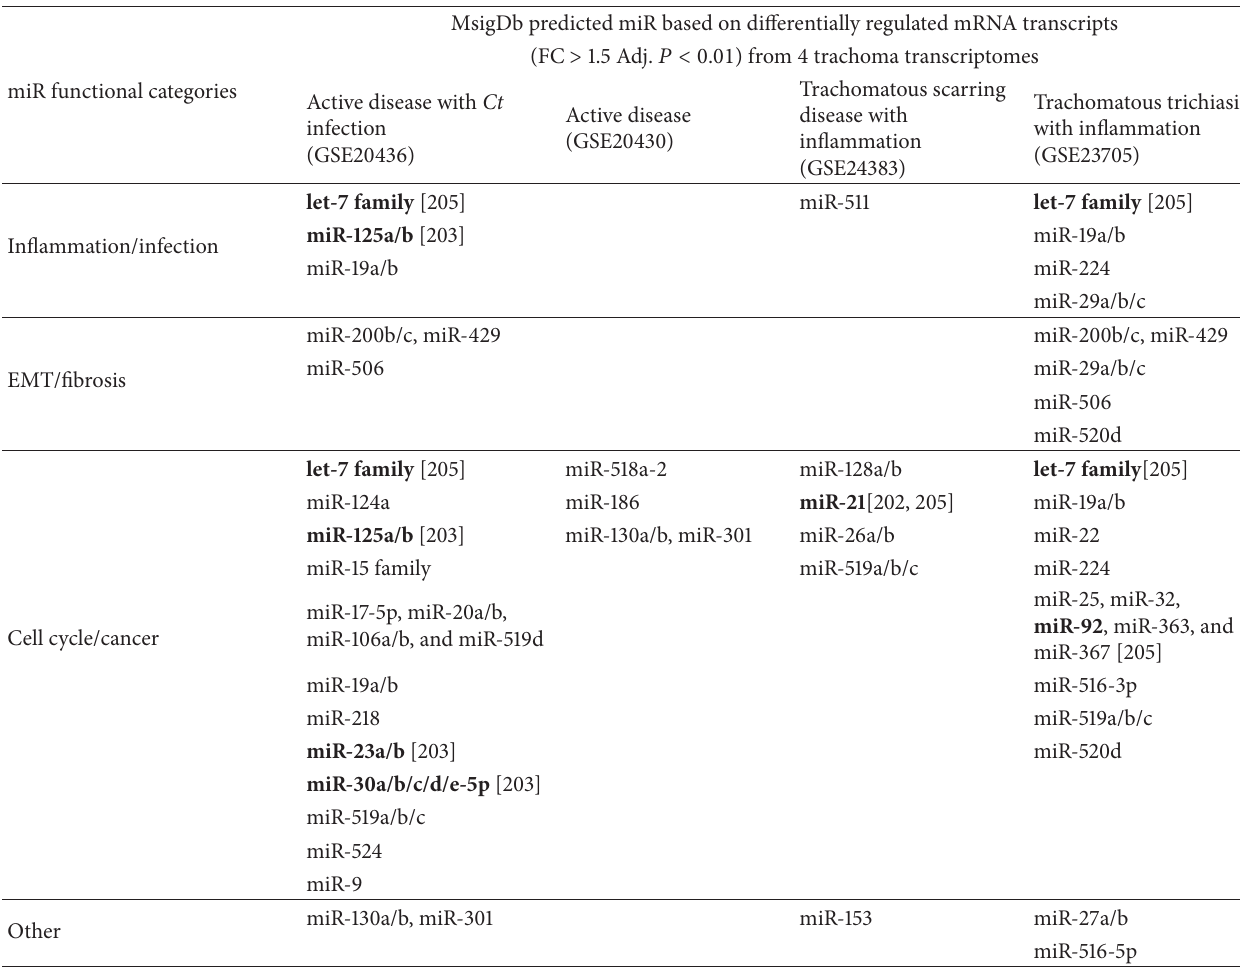
Table 1: miR predicted to regulate differentially expressed transcripts from four array